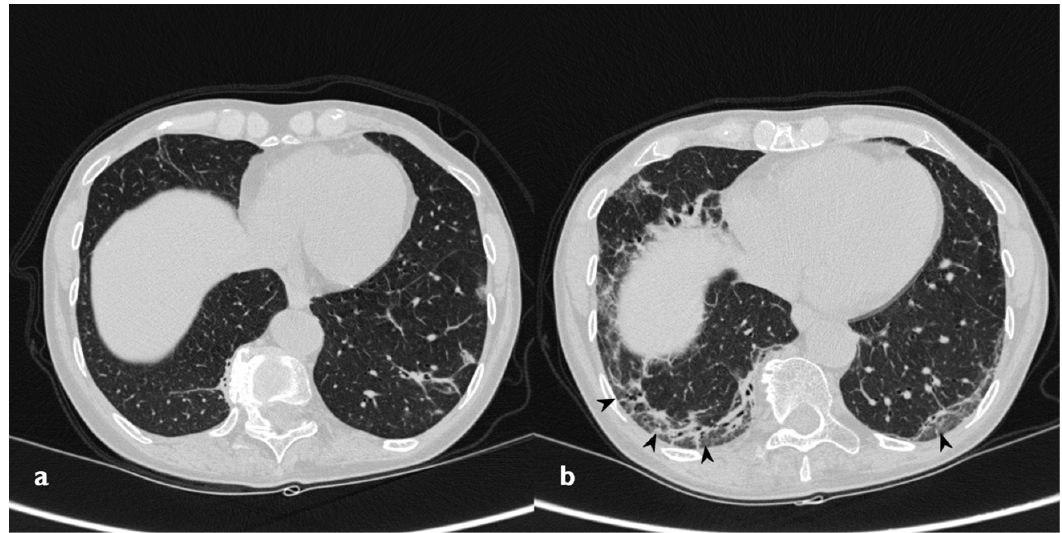
Figure 16. Fibrosing evolution. On the left ( a ): baseline HRCT. On the right ( b ): HRCT after 11 months of steroid therapy; new signs of fibrosis-sub-pleural basal reticulations and architectural distortion (arrowheads). Table 11. Different kinds of evolution of the 21 patients who received steroid treatment.